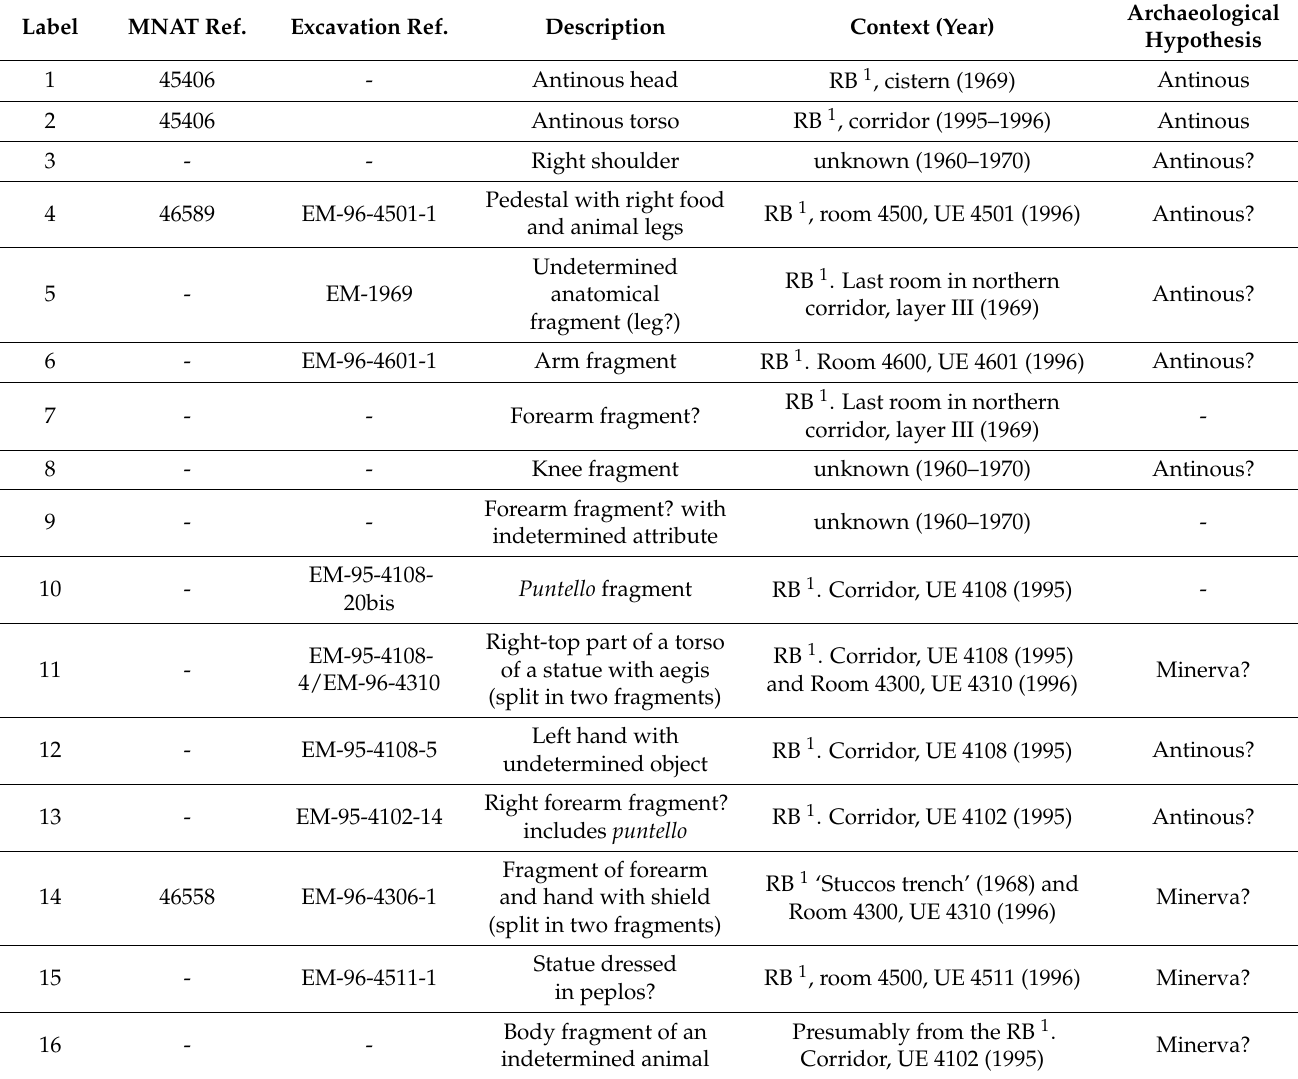
Table 1. Sampled marble fragments, with indication of museum and excavation references, a short description, the context where they were found, and the year of the finding, along with the most accepted archaeological interpretation about their